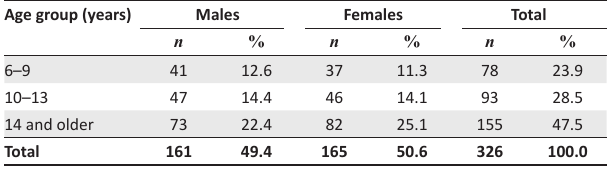
TABLE 2: Distribution of participants according to age.